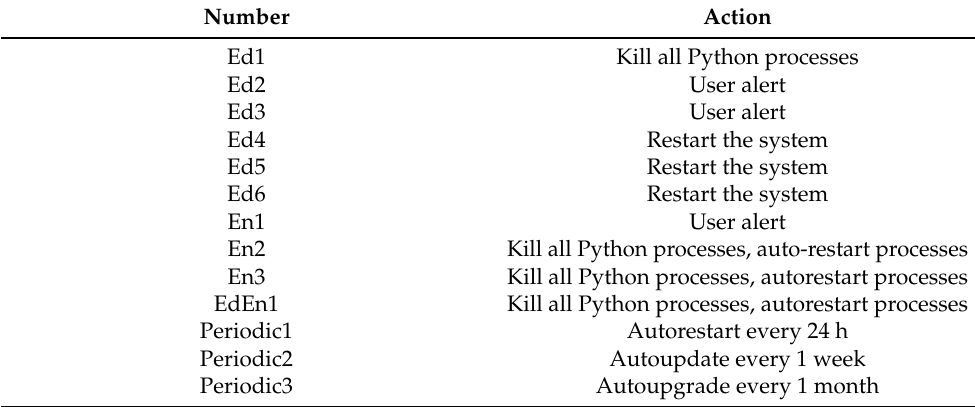
Table 5. Respective actions per IoT error.